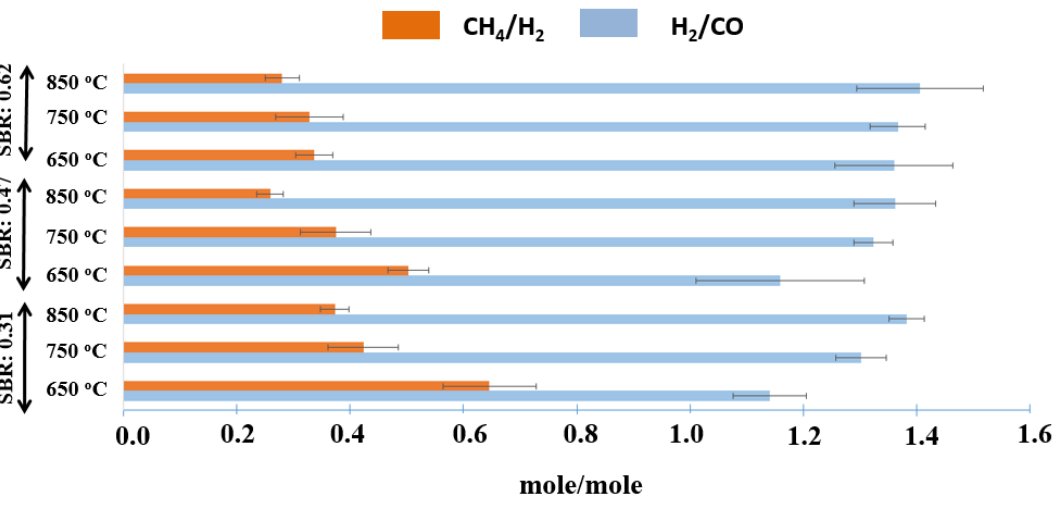
Figure 4. H 2 /CO and CH 4 /H 2 molar ratio values for the steam gasification of fuel pellets at different gasification temperatures and steam-to-biomass ratios.